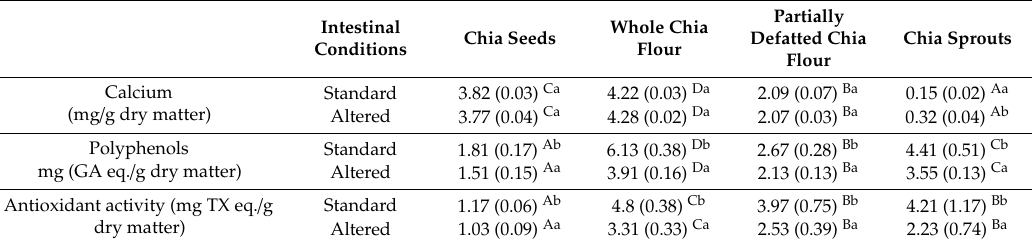
di ff erences ( p < 0.05) between intestinal conditions (standard and alternated). GA eq., gallic acid equivalent; TX eq., trolox